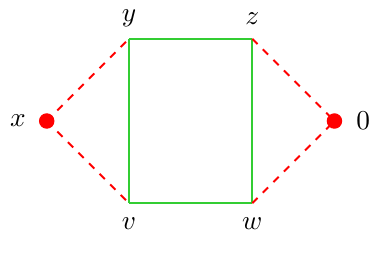
Figure 9 . Symmetry factor is